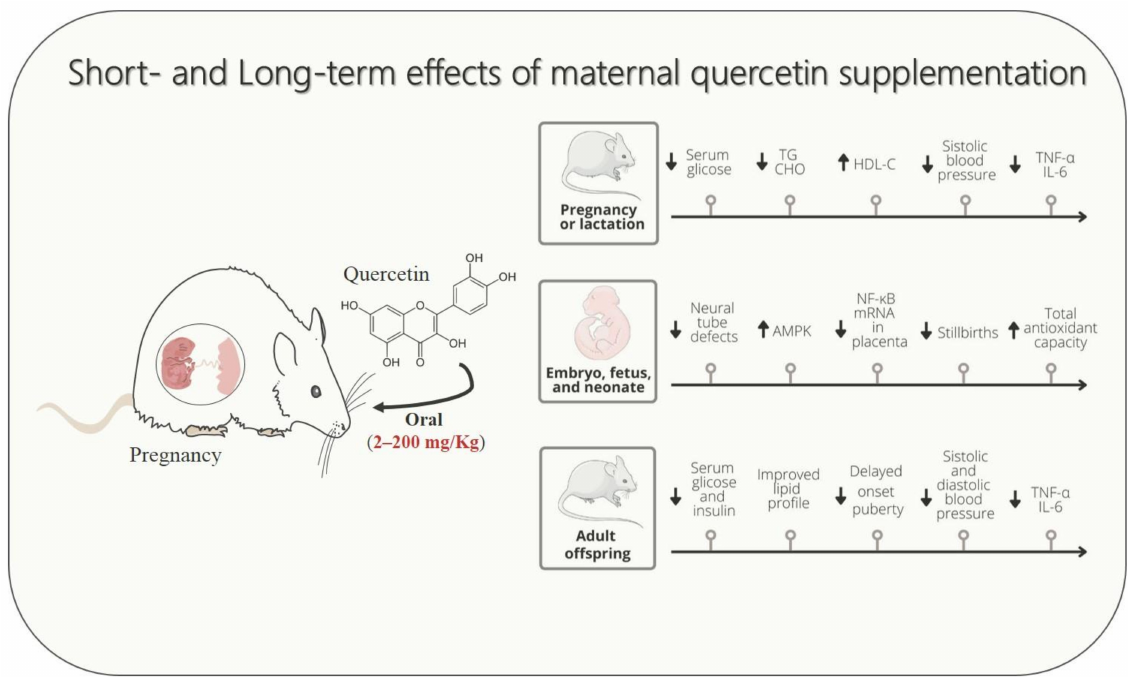
Figure 1. Schematic drawing showing that maternal quercetin supplementation improves cardio- metabolic, inflammatory, and oxidative stress parameters in dams, fetuses, and offspring. The up arrow ↑ represents increase, down arrow ↓ represents